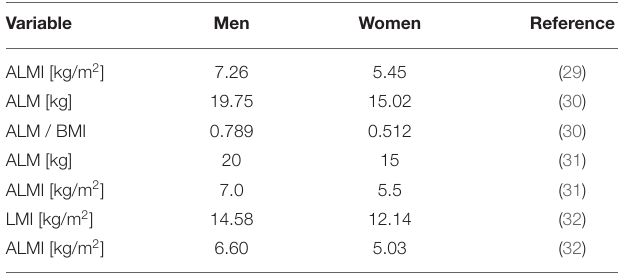
TABLE 1 | Cutoff points proposed to discriminate between the normal and low lean